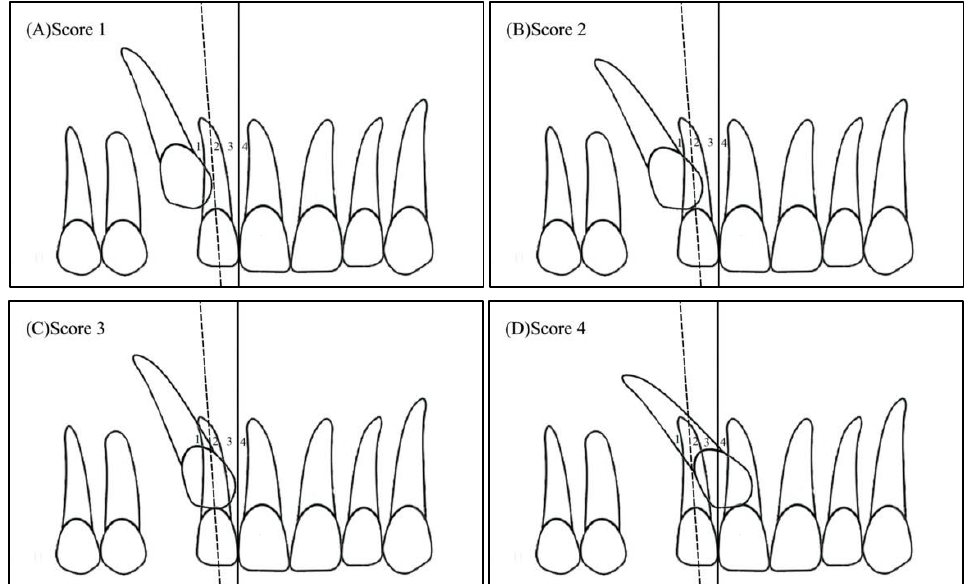
Figure 2. Horizontal position of the impacted canine: ( A ) Sector 1—canine overlapping less than half the width of the lateral incisor, ( B ) Sector 2—canine overlapping half the width of the lateral incisor, ( C ) Sector 3—canine completely overlapping the lateral incisor, ( D ) Sector 4—enclosing all areas mesial to Sector 3.